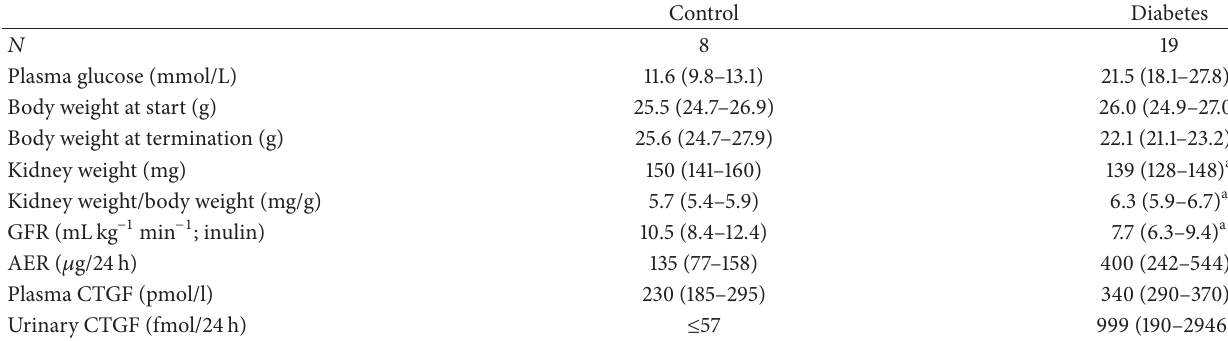
Table 1: Characteristics of control mice and diabetic mice (parameters at termination of the